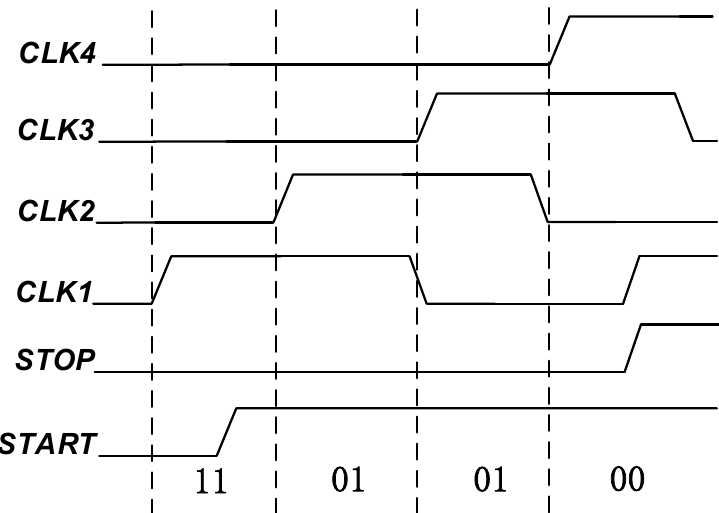
Figure 4. Schematic diagram of traditional clock compression TDC coding principle.